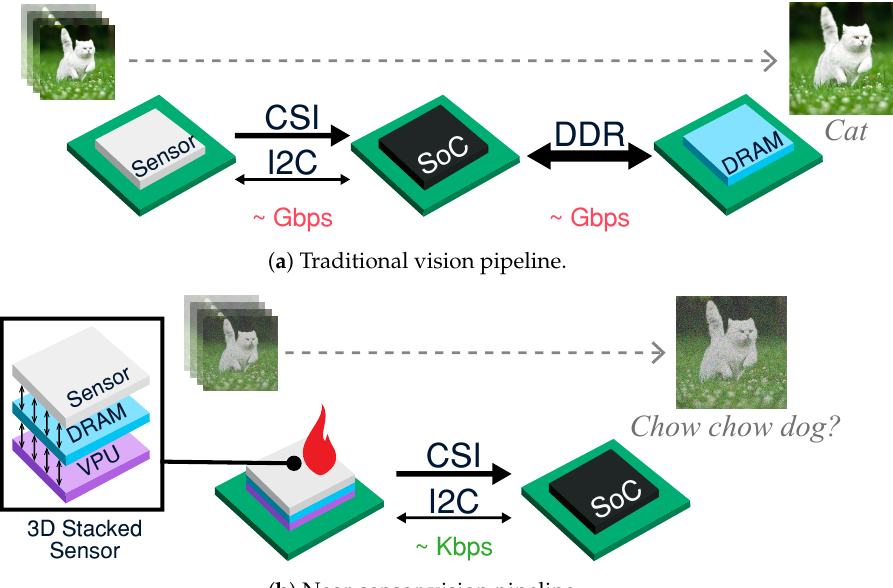
Figure 1. Due to energy-expensive interface data movements, traditional pipelines are inefficient. Near-sensor processing helps greatly reduce data traffic promoting energy-efficiency. However, it generates heat increasing sensor temperature, thereby resulting in noisy images potentially degrading task